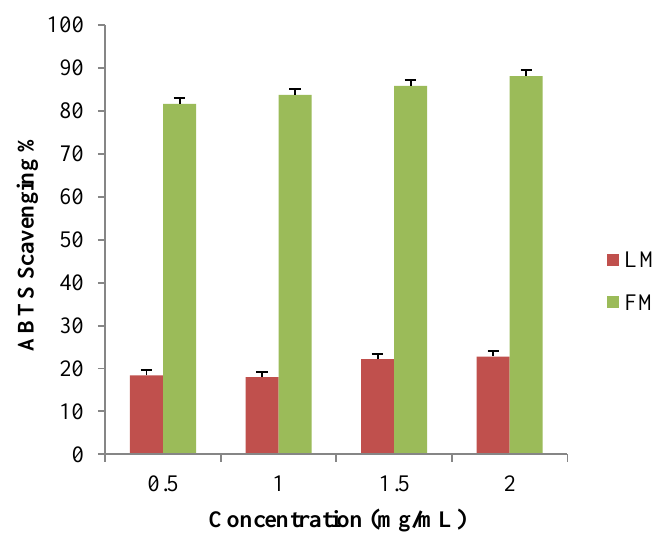
Figure 4. ABTS + scavenging percentage of LM and FM extracts.